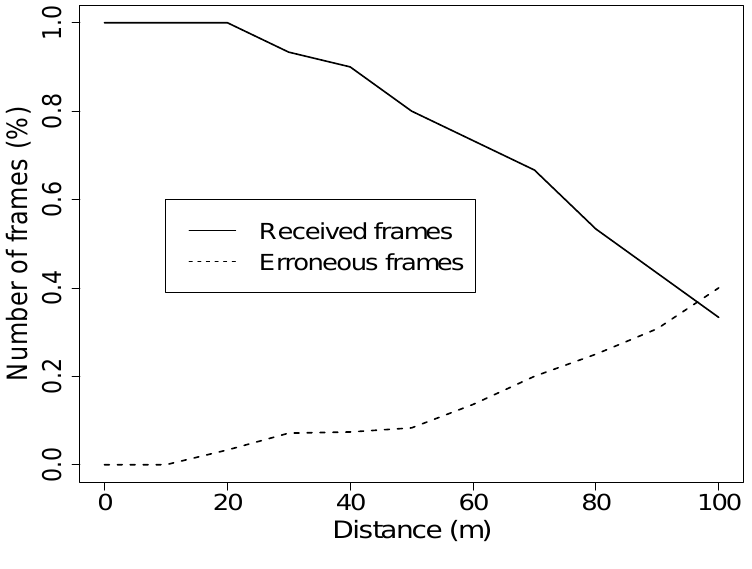
Figure 8. Average number of frames received and erroneous messages in a Primary- Secondary radio link experiment for all the distances.